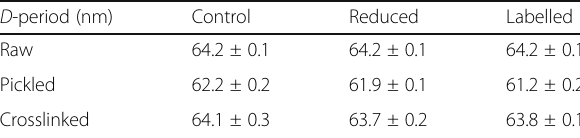
Table 1 Collagen D -periodicity at different processing stages in control, reduced and labelled skin samples. The D -period decreased for all samples starting from raw to the pickled stage, then increased at the crosslinked